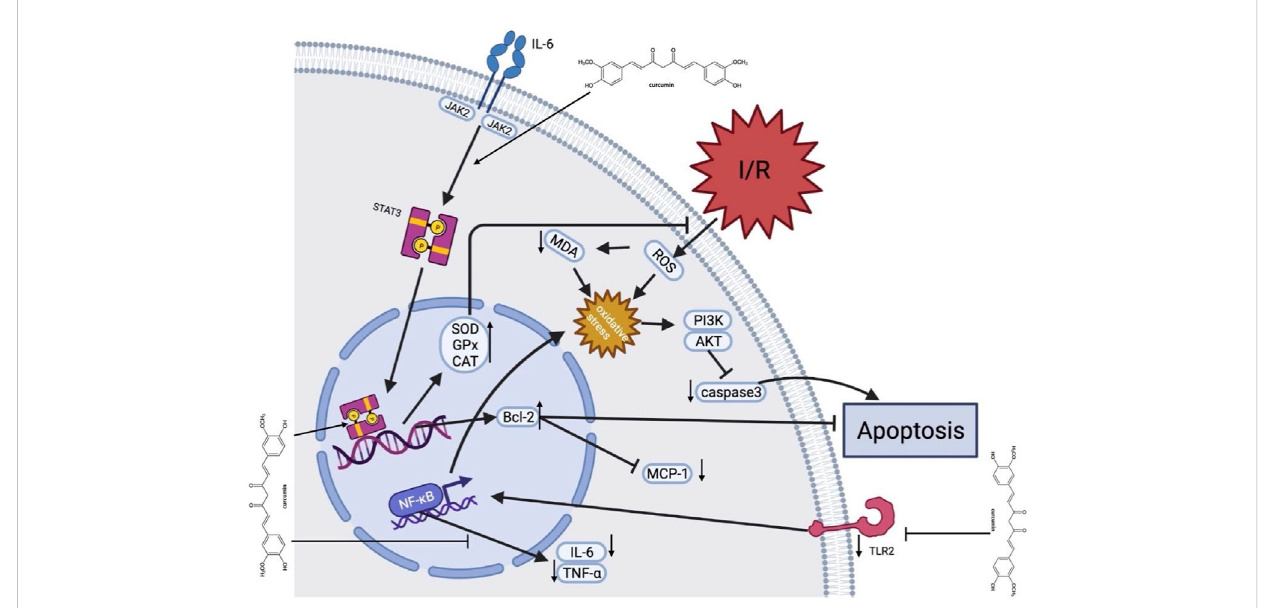
A schematic representation of cardioprotective mechanisms of curcumin for myocardial ischemia/reperfusion injury. After I/R occurs, curcumin inhibits cell apoptosis byactivating JAK2/STAT3 pathwayand relieving oxidative stress, with upregulated SOD, GPx andCAT expression, decrease ofROS production, and upregulated Bcl-2. In addition, curcumin inhibits the TLR2 and NF- κ B pathways on the cell membrane surface via downregulation of TNF- α and IL-6. Moreover, curcumin suppresses caspase-3 expression to inhibit apoptosis. AKT, protein kinase B; Bcl-2, B-cell lymphona-2; CAT, catalase; GPx, Glutathione Peroxidase; I/R, ischemia/reperfusion; IL-6, interleukin-6; JAK2, Janus kinase two; McP-1, Monocyte chemotactic protein one; MDA, malondialdehyde; MPO, myeloperoxidase; PI3K, Phosphatidylinositide 3-kinases; ROS, Reactive oxygen species; Superoxide dismutase; STAT3, signal and activator of transcription three; TLR2, Toll-like receptor two; TNF- α , tumor necrosis factor α